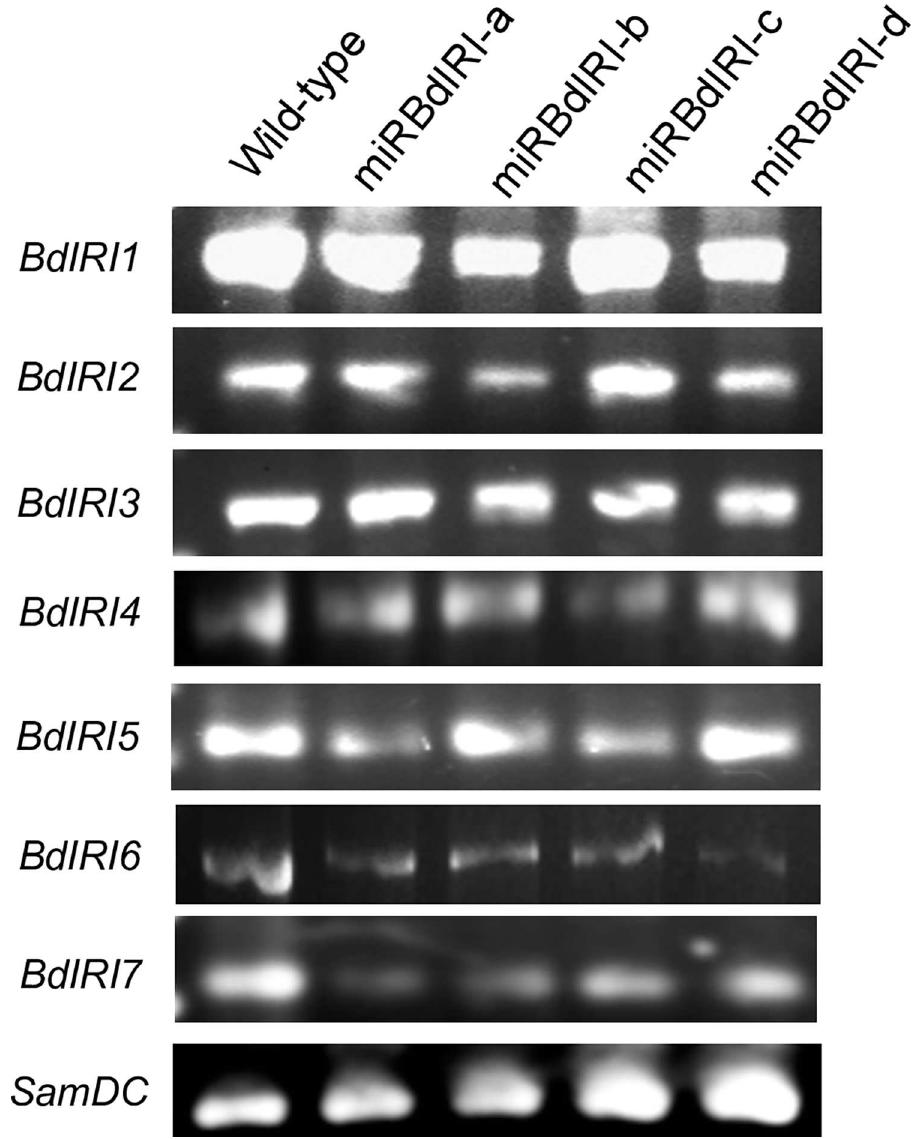
Fig 9. Transcript analysis of BdIRI s in wild-type and knockdown (miRBdIRI) plants. Transcripts were amplifiedfor four independentlines (miRBdIRIa-d) as well as wild-typeplants with PCR performed using the isoform-specific primers listed in Table 1B. The SamDC transcript was used as a PCR loadingreference. Assays were done in